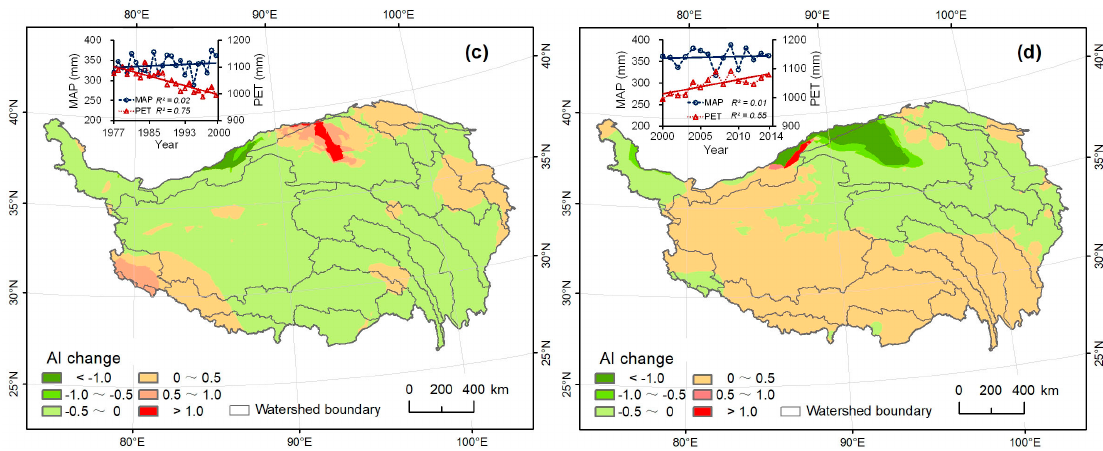
Figure 5. Variable changes in climatic factors. ( a , b ) represent annual change in MAAT and spatial patterns of annual change rate in MAAT over the TP during the periods 1977–2000 and 2000–2014, respectively; ( c , d ) represent annual changes in MAP and PET and spatial patterns of annual change rate of AI over the TP during the periods 1977–2000 and 2000–2014, respectively.